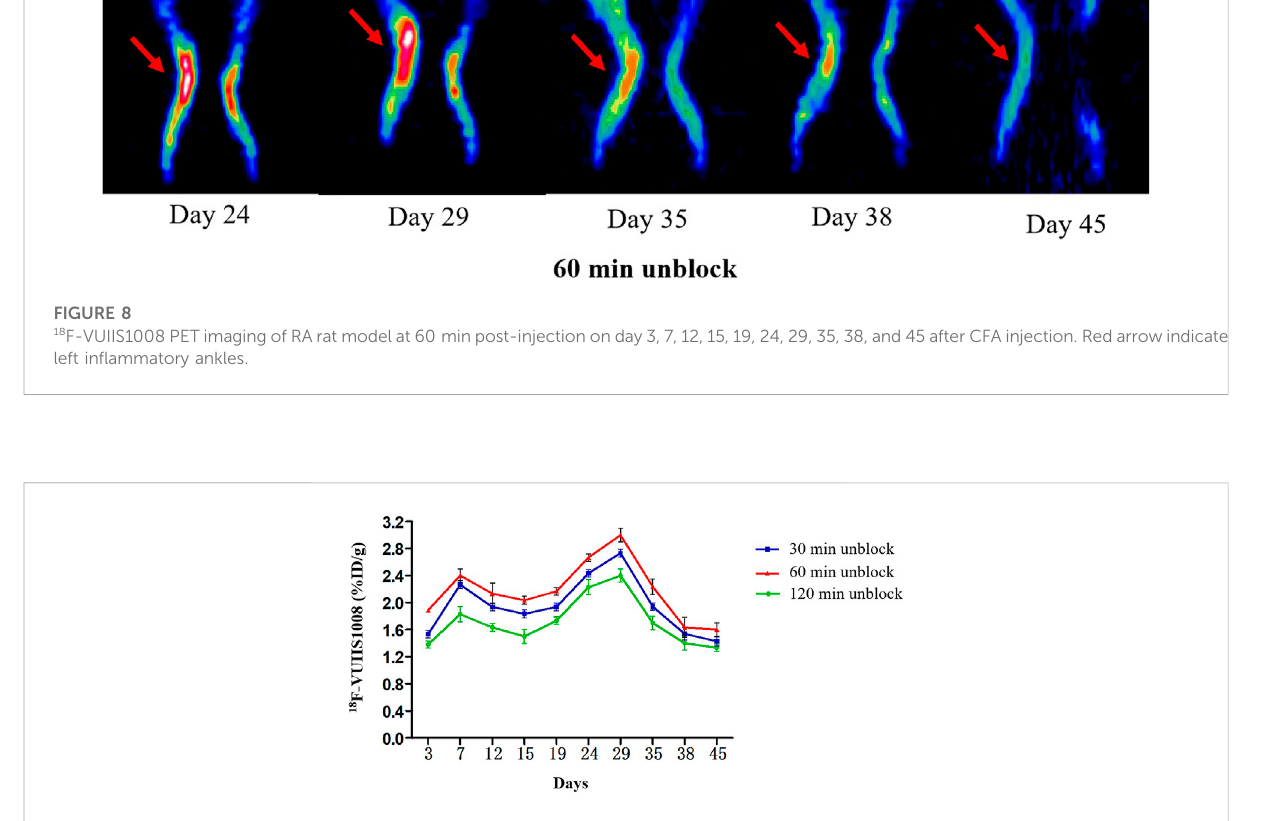
FIGURE 9 Quantitative analysis of 18 F-VUIIS1008 uptake in the left in fl ammatory ankles at different time post-injection on different day based on PET imaging. Peak uptake was found on day